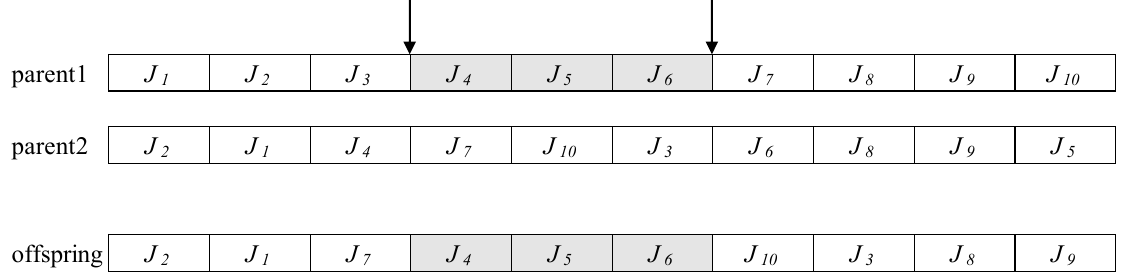
Figure 4. Illustration of OX crossover. For each offspring generated by OX crossover, the parent solution’s features may